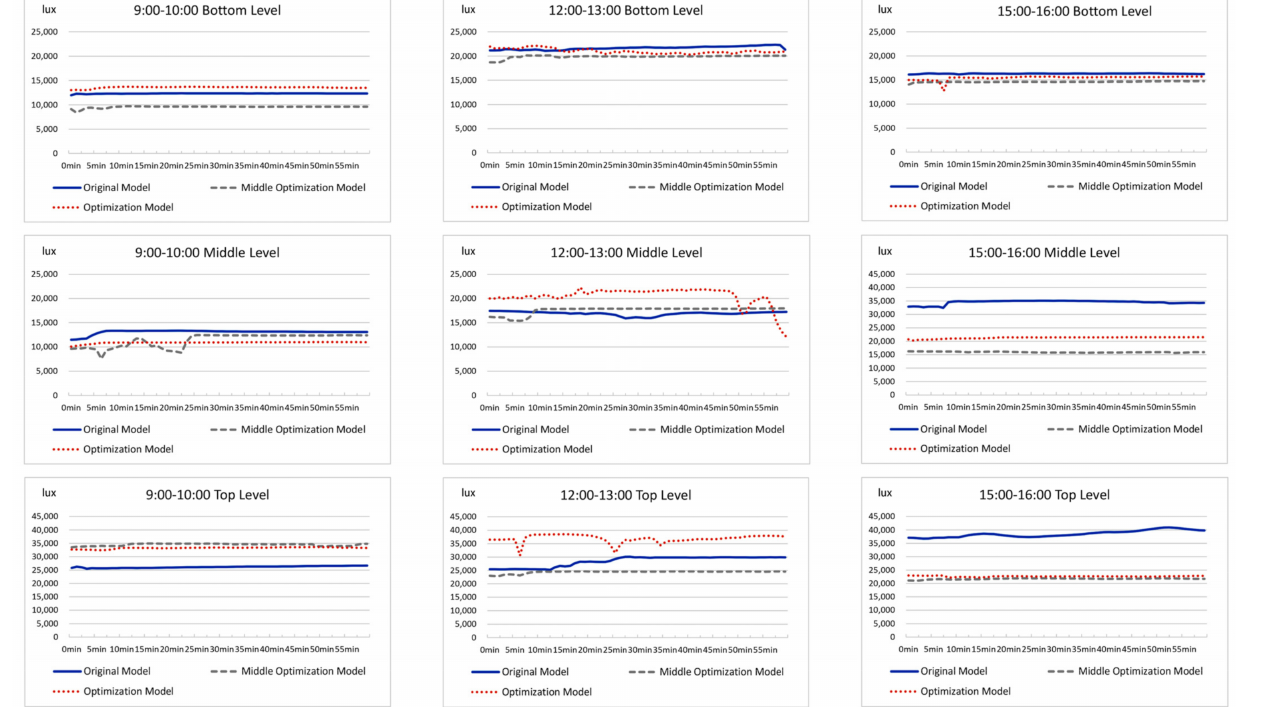
Figure 24. The light intensity comparison of original, optimized, and best-optimized models.